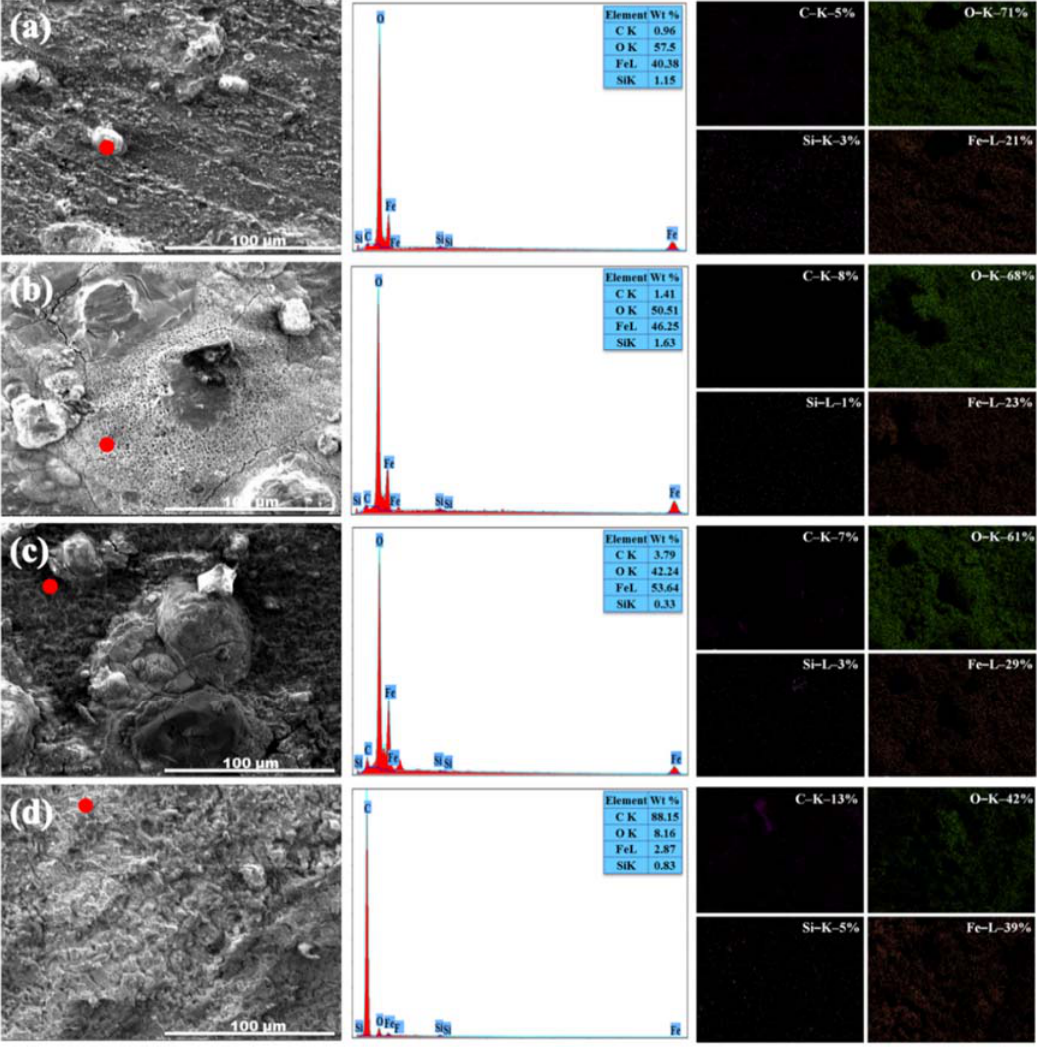
Figure 8. SEM micrographs, EDS spectra, and EDS maps of corroded surfaces of ( a ) non-treated, ( b ) TMSA, ( c ) TMDA, and ( d ) TMTA treated AISI 1345 steel in 5 vol% HCl solution.